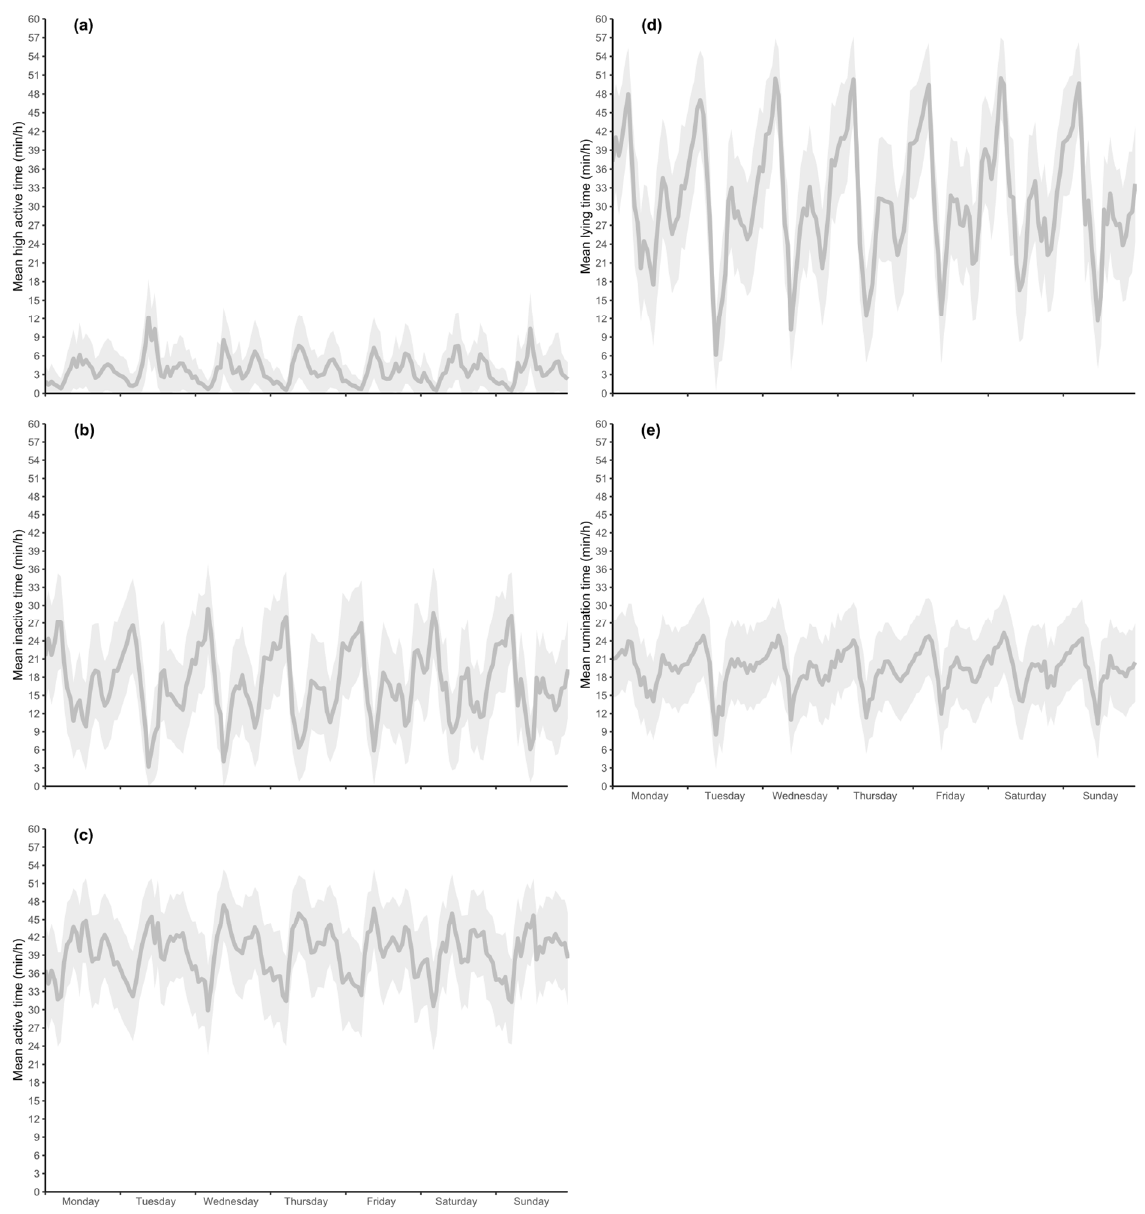
Figure 2. ‘Normal’ behavior examined by an ear-tag based accelerometer in 428 clinically healthy calves over one week. Mean (dark grey line) and SD (light gray areas) in minutes per hour of the parameters high active ( a ), inactive ( b ), active ( c ), lying ( d ), and rumination ( e ) times are presented.